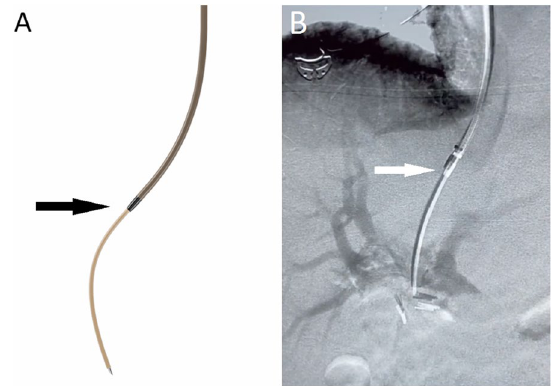
Fig. 1 A . Schematic picture and B . Fluoroscopy image demonstrating access of the portal vein from the hepatic vein using the bi-directional functionality of the Scorpion X access kit. The inflection points between needle and cannula which highlight bi-directional movement are highlighted with